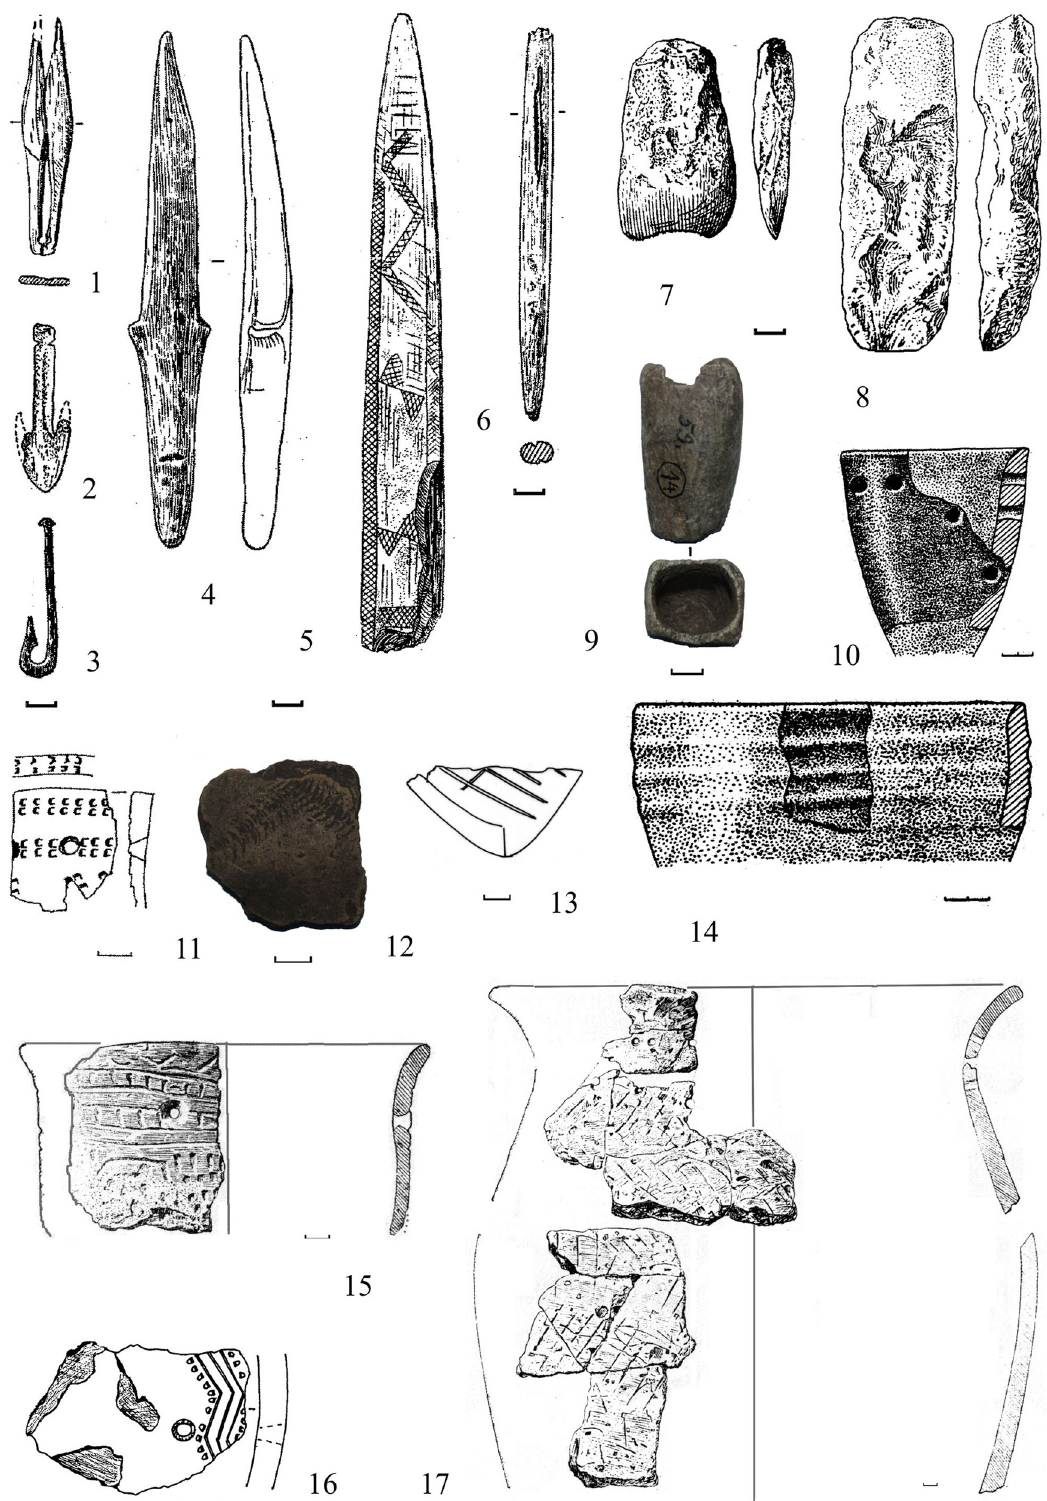
Figure 2: Materials of the Sursky